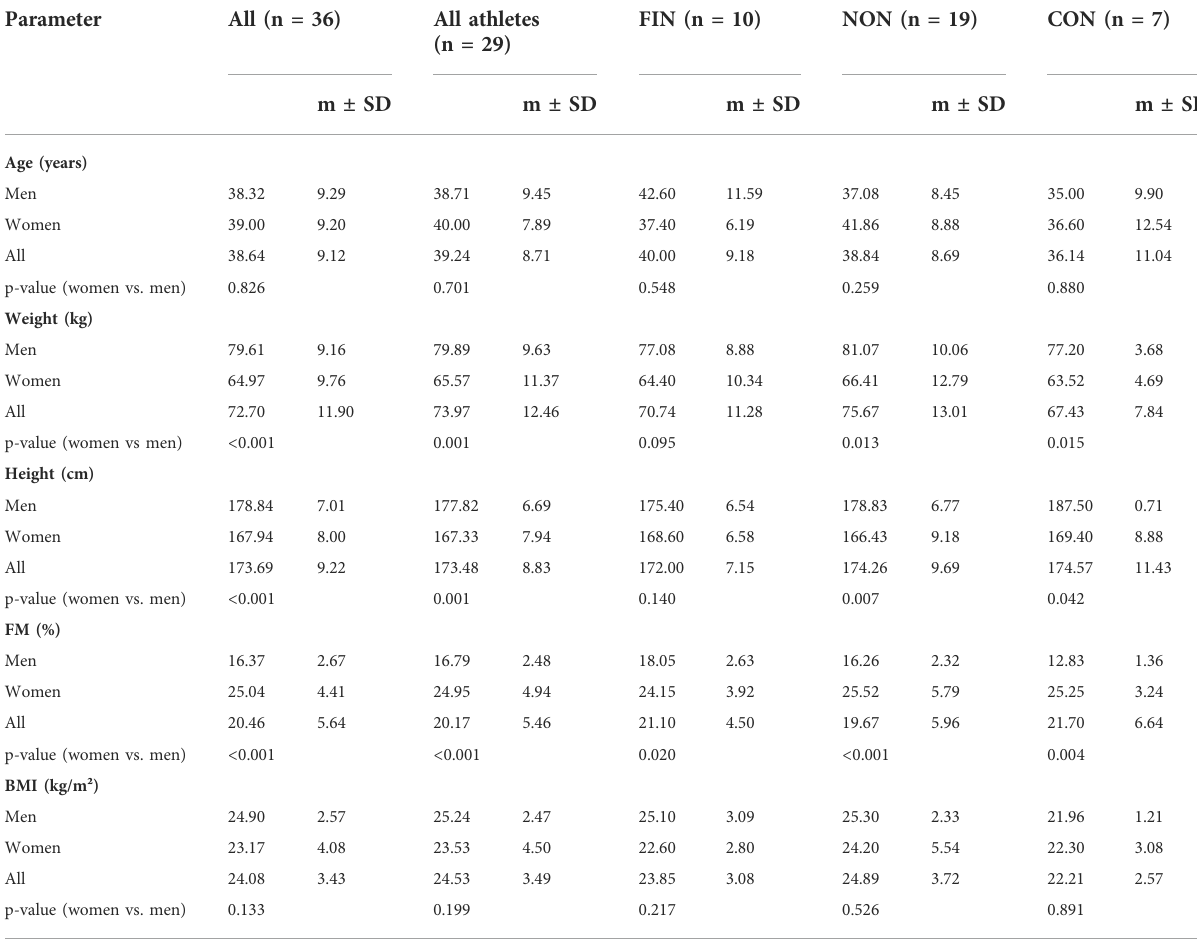
TABLE 1 Subject demographics at baseline for all participants and in subgroups. FIN = Finisher, NON = Non- fi nisher, CON = Control group, FM = fat mass, BMI = body mass index, m = mean, SD = Standard Deviation.